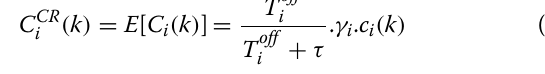
Interference with external PU